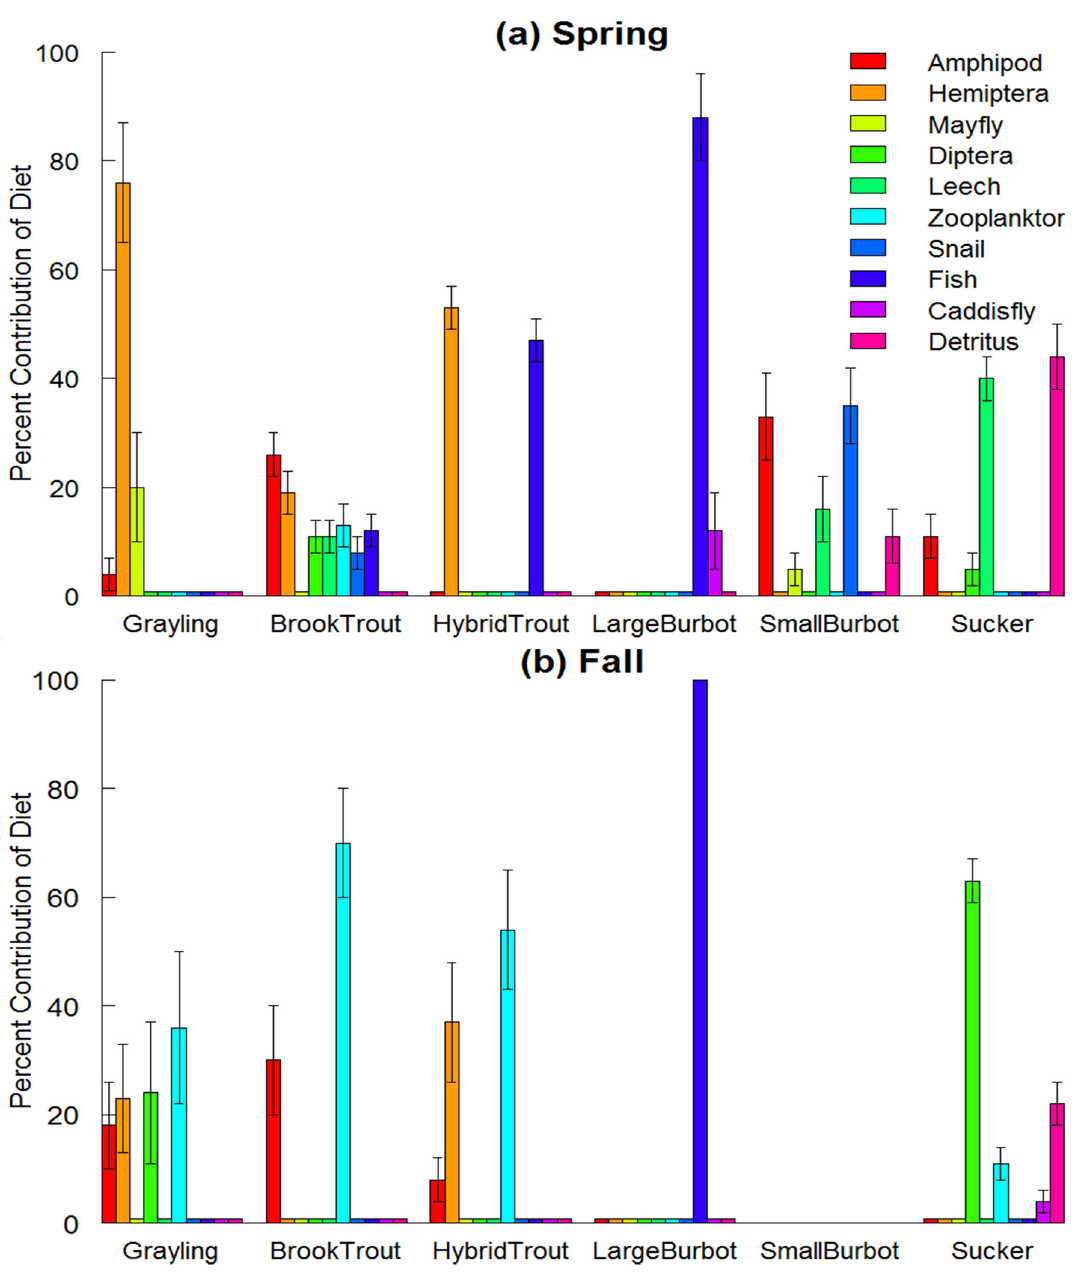
Fig 6. Contributions (% mean ± 1 SE) of dietary sources to fishes during spring (a) and fall (b) based on a two-isotope ( δ 15 N and δ 13 C) Bayesian mixing model with informative priors (Parnell et al ., 2010;